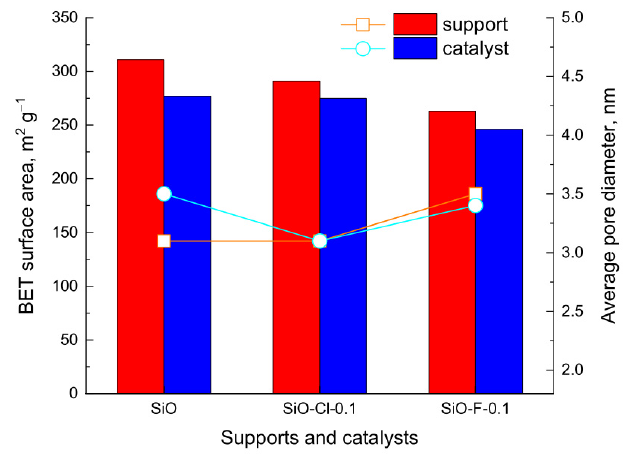
Figure 6. BET surface areas (bars) and average pore diameters (dots) of supports (red) and iridium catalysts (blue).